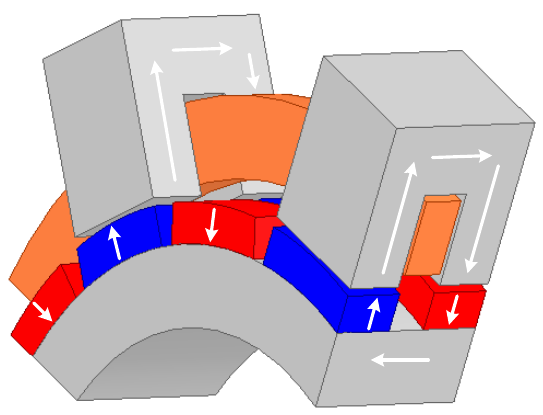
Figure 2. A fragment of the TFM segment with the lines marked the magnetic field.